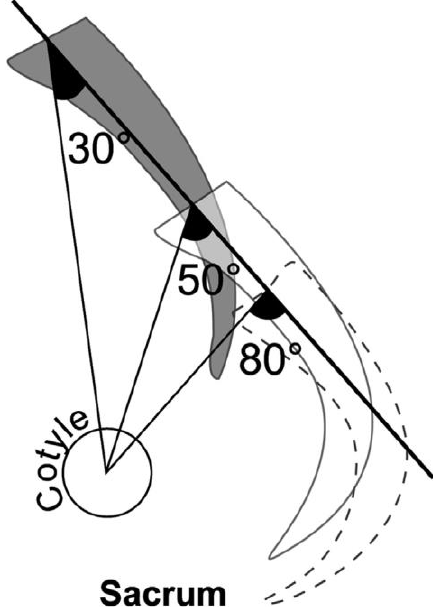
Figure 1. Sagittal model of pelvic incidence. Three schematic steps are depicted: a theoretical ances- tral stage (30°), an australopithecine stage (50°), and an extreme range for humans (80°). Adapted stage (30 ◦ ), an australopithecine stage (50 ◦ ), and an extreme range for humans (80 ◦ ). Adapted from from ref. [11] with permission from Elsevier. ref. [11] with permission from